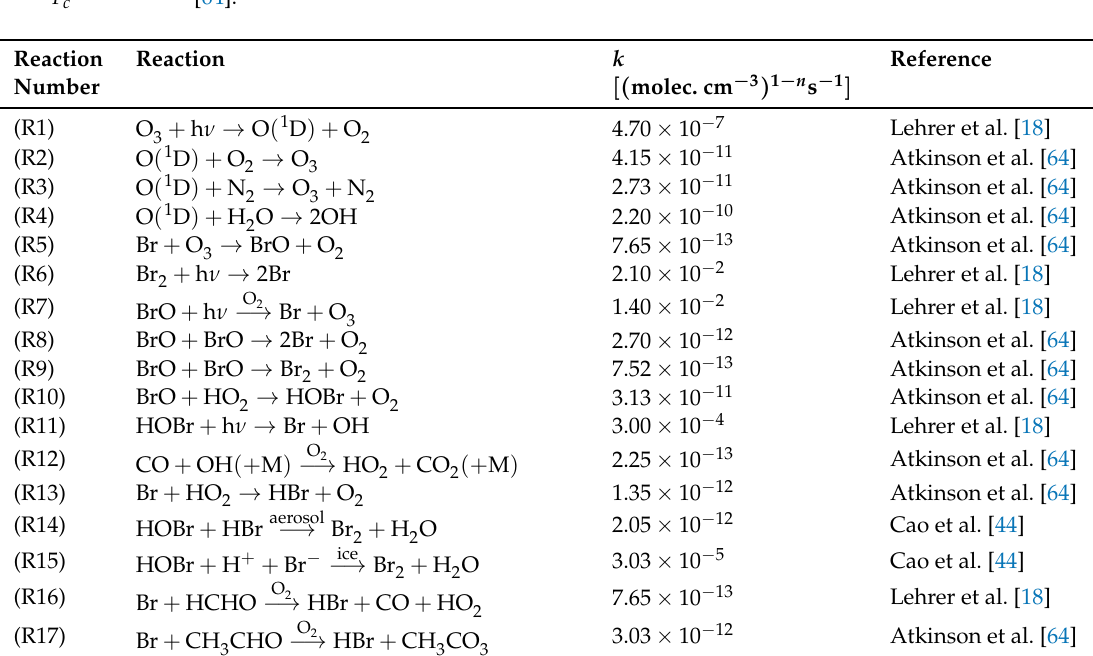
Table A1. The complete list of chemical reactions used in a present study, a constant temperature T = 258K is implemented, and the rate of third-body reactions is estimated as k = k ∞